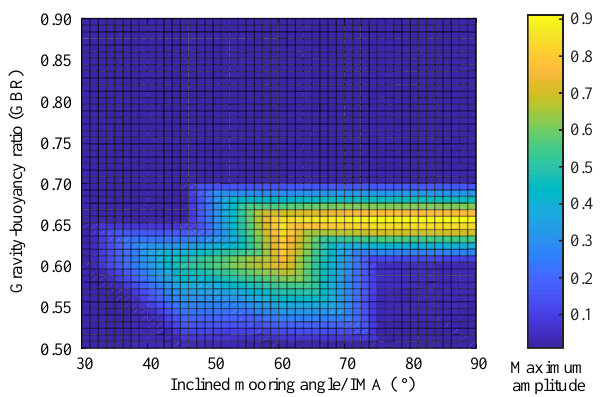
Figure 9. Maximum displacement amplitude of SFT cable with different combinations of GBR and IMA (frozen parameters: v 0 = 0, H = 0 and T = 0).